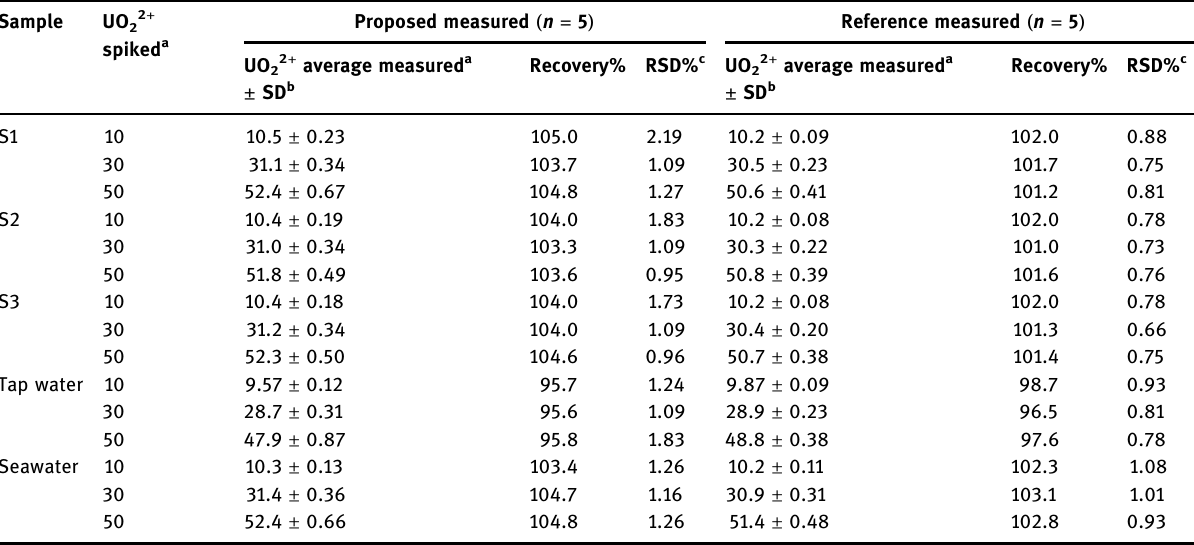
Table 2: Application of L chemosensor for assessment of UO 22 + in di ff erent samples Sample UO 22 + spiked